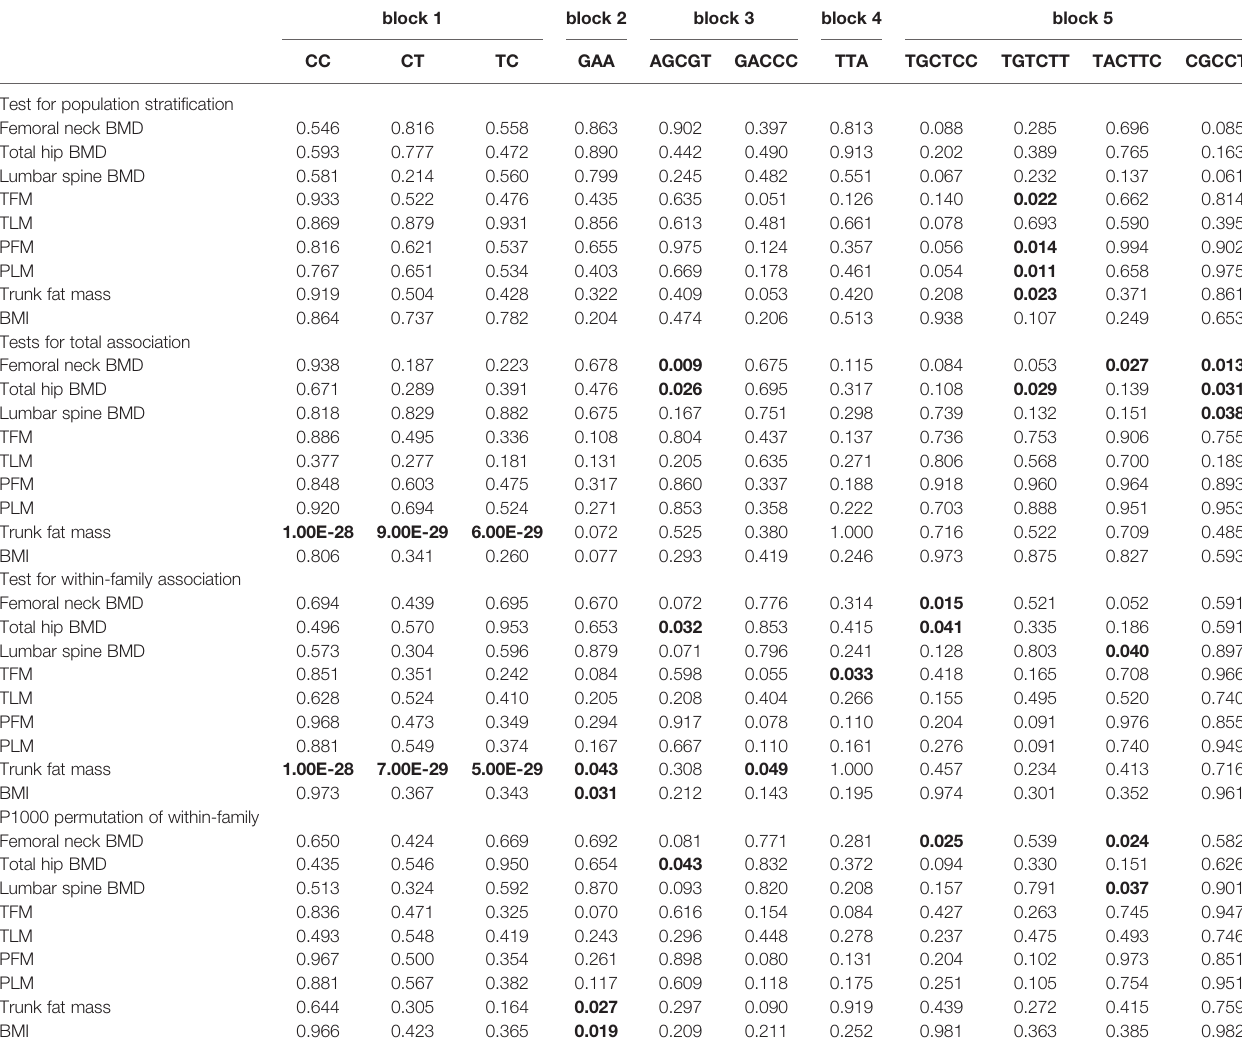
TABLE 4 | QTDT results for the associations between the haplotype and phenotype variations.